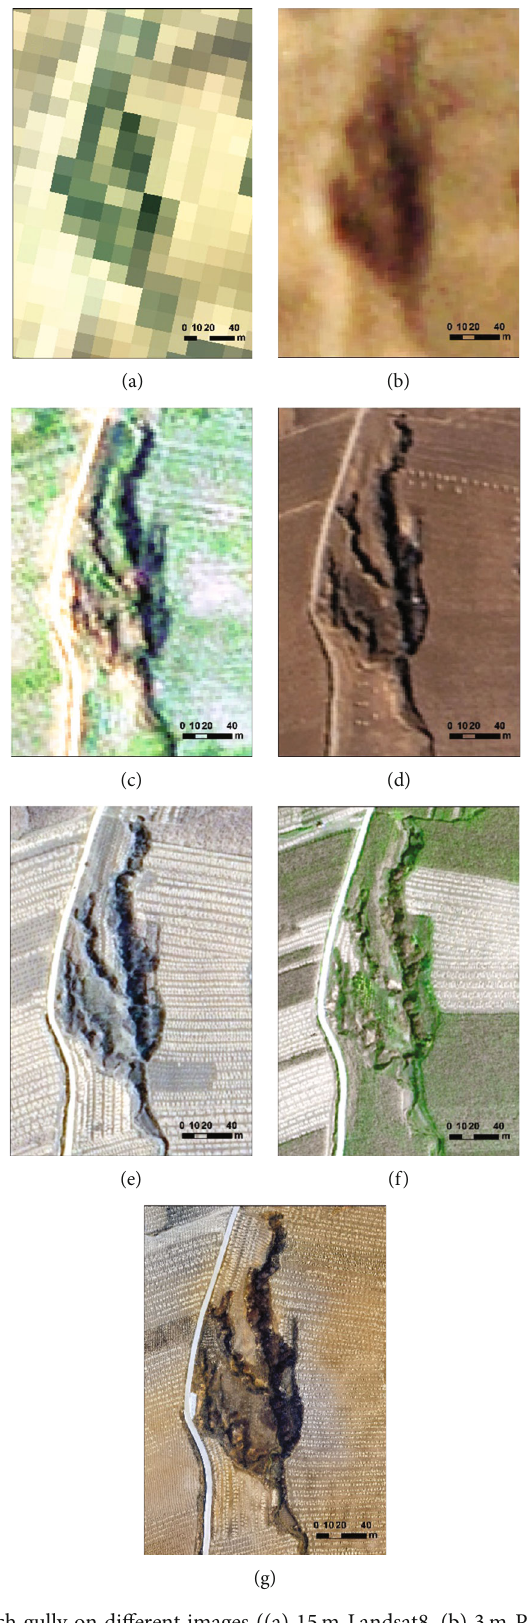
Figure 4: Image characteristics of branch gully on di ff erent images ((a) 15m-Landsat8, (b) 3 m-Planet Labs, (c) 2.5m-Alos, (d) 2m-ZY3, (e) 0.7m-Pleiades, (f) 0.5 m-DMC, and (g)